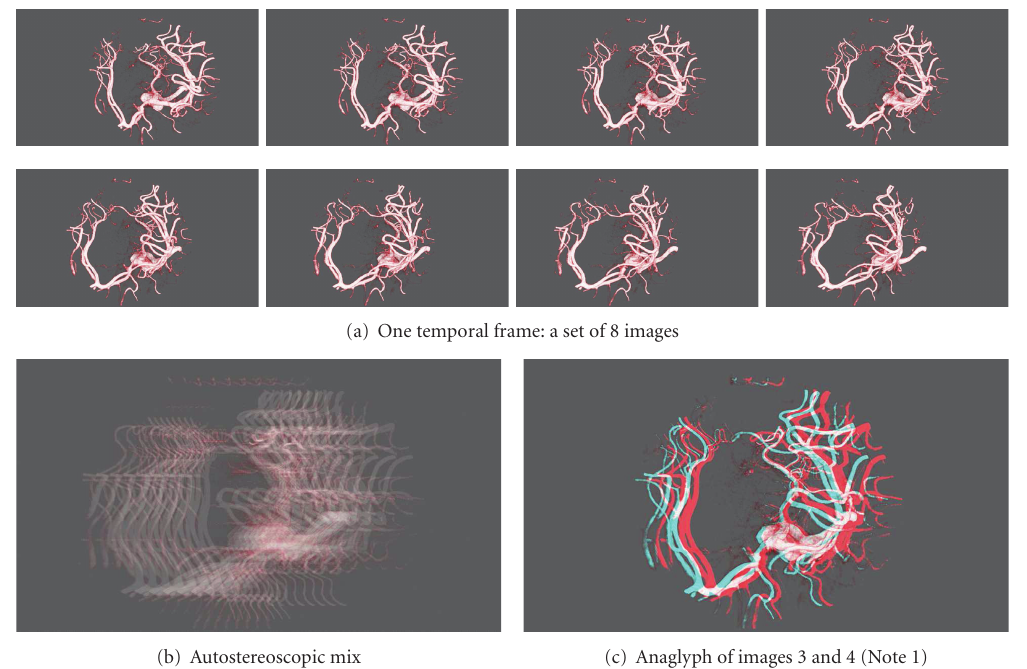
Figure 5: Images synthesis of image of an